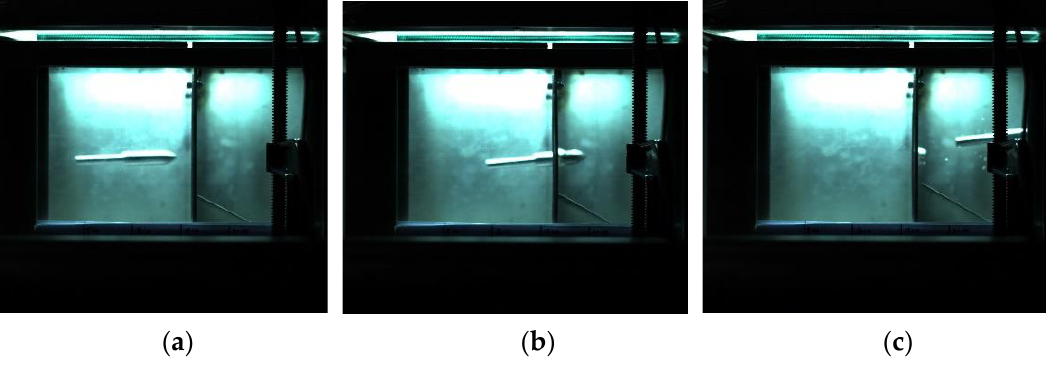
Figure 12. Simulation and experiment comparison: ( a ) experiment results; ( b ) simulation results.